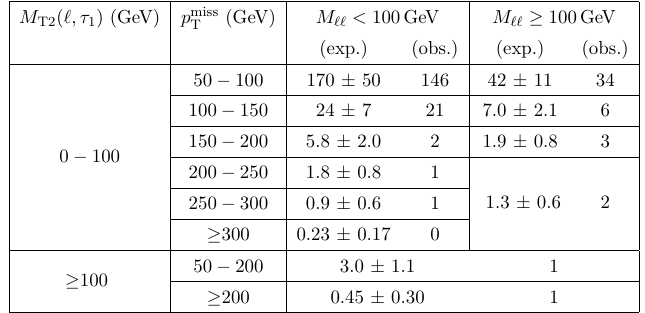
Table 17 . Category F: expected and observed yields in events with one e or (cid:22) and two (cid:28) each bin, the (cid:12)rst number corresponds to the expected yield and its uncertainty, and the second denotes the observed yield. The uncertainty denotes total uncertainty in the yield.